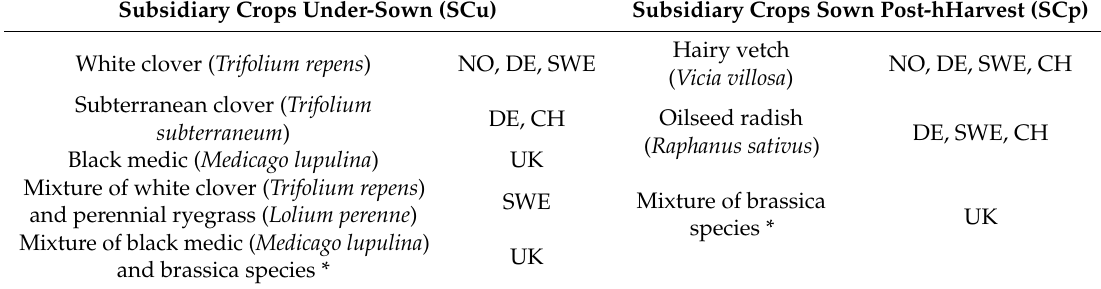
Table 2. Subsidiary crop species and the sites where they were cultivated. Subsidiary crops were either sown together with or under-sown (SCu) into the first crop (winter wheat) or sown after the harvest of the first crop (SCp). Subsidiary Crops Under-Sown (SCu) Hairy vetch NO, DE, SWE, CH White clover ( Trifolium repens ) NO, DE, SWE DE, CH subterraneum )